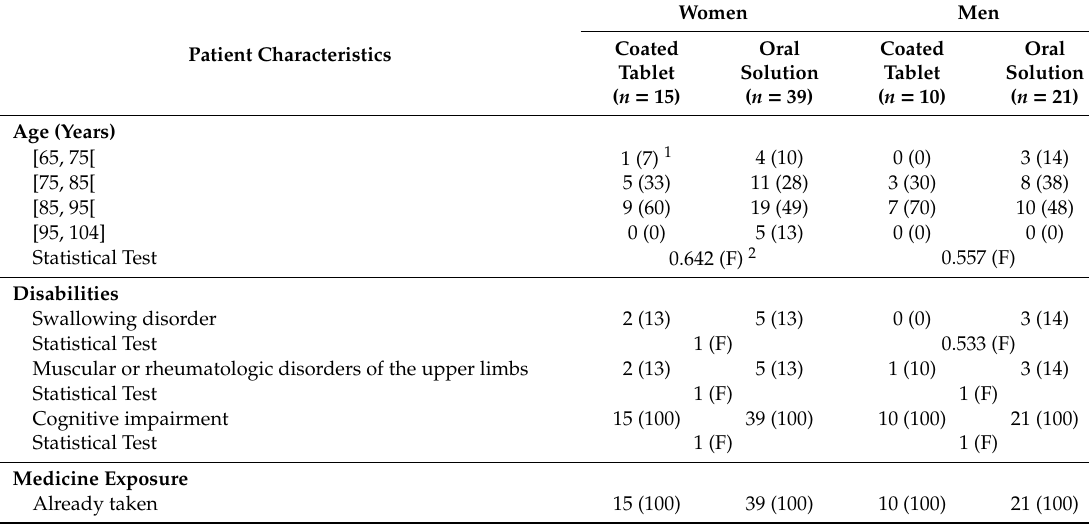
Figure 2. Acceptability of the original formulations of memantine (Ebixa ® ) in older women. Table 1. Characteristics of the patients treated with the original formulations of memantine (Ebixa ®